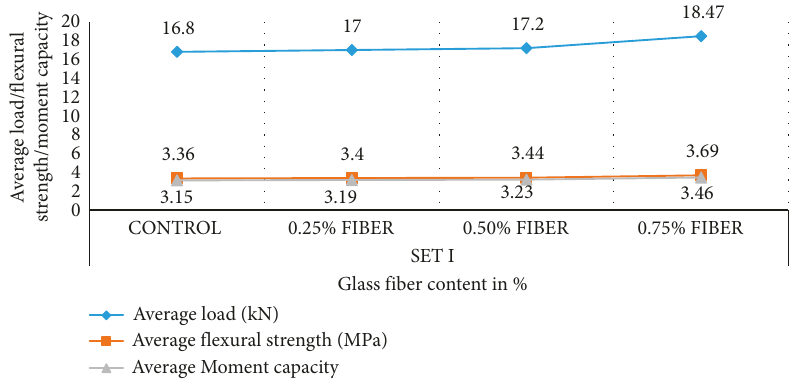
Figure 6: Average load/flexural strength/moment capacity versus glass fiber content on 21st